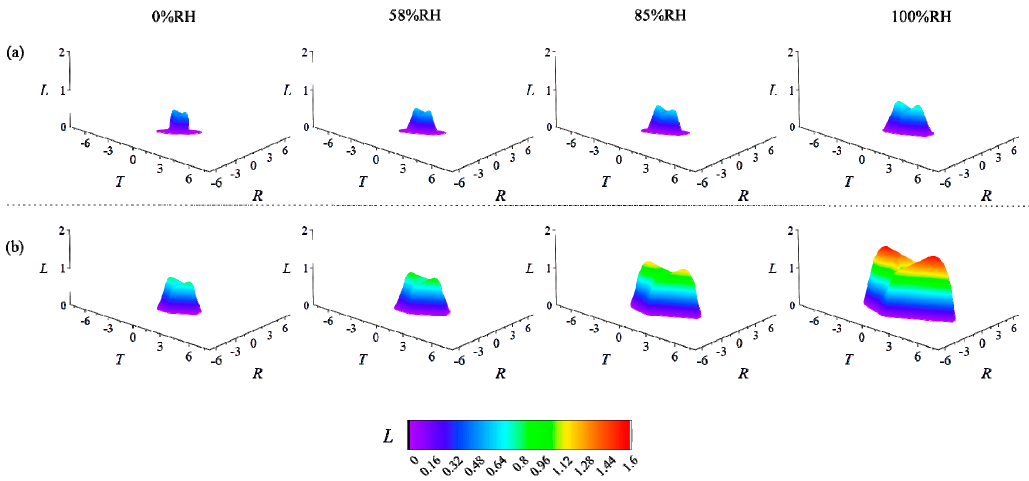
Figure 4. Load-directional dependence of poplar ( a ) and Chinese fir ( b ) wood compliance by the three-dimensional representation at four RH levels (0, 58, 85 and